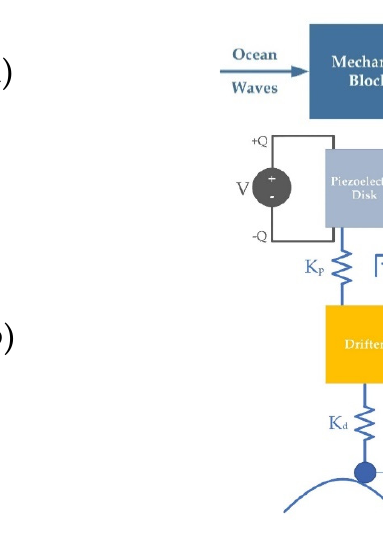
Figure 5. ( a ) Steps of the dynamic modelling from ocean waves to output voltages; ( b ) Schematics of the proposed dynamic model and its free-body diagram.